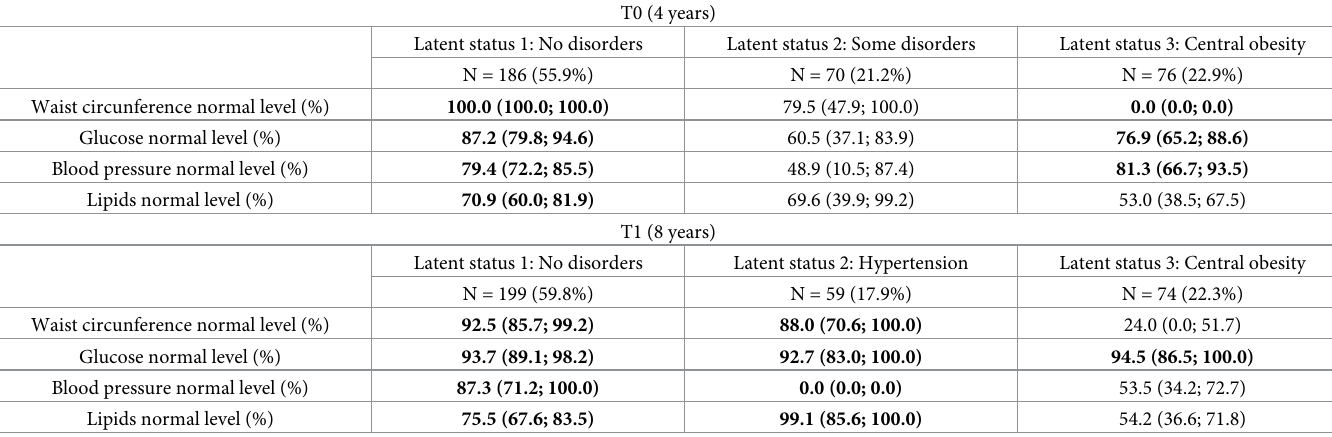
Table 2. Item-response probabilities and confidence intervals of the three latent status model selected, and the prevalence of the latent statuses at each time point.